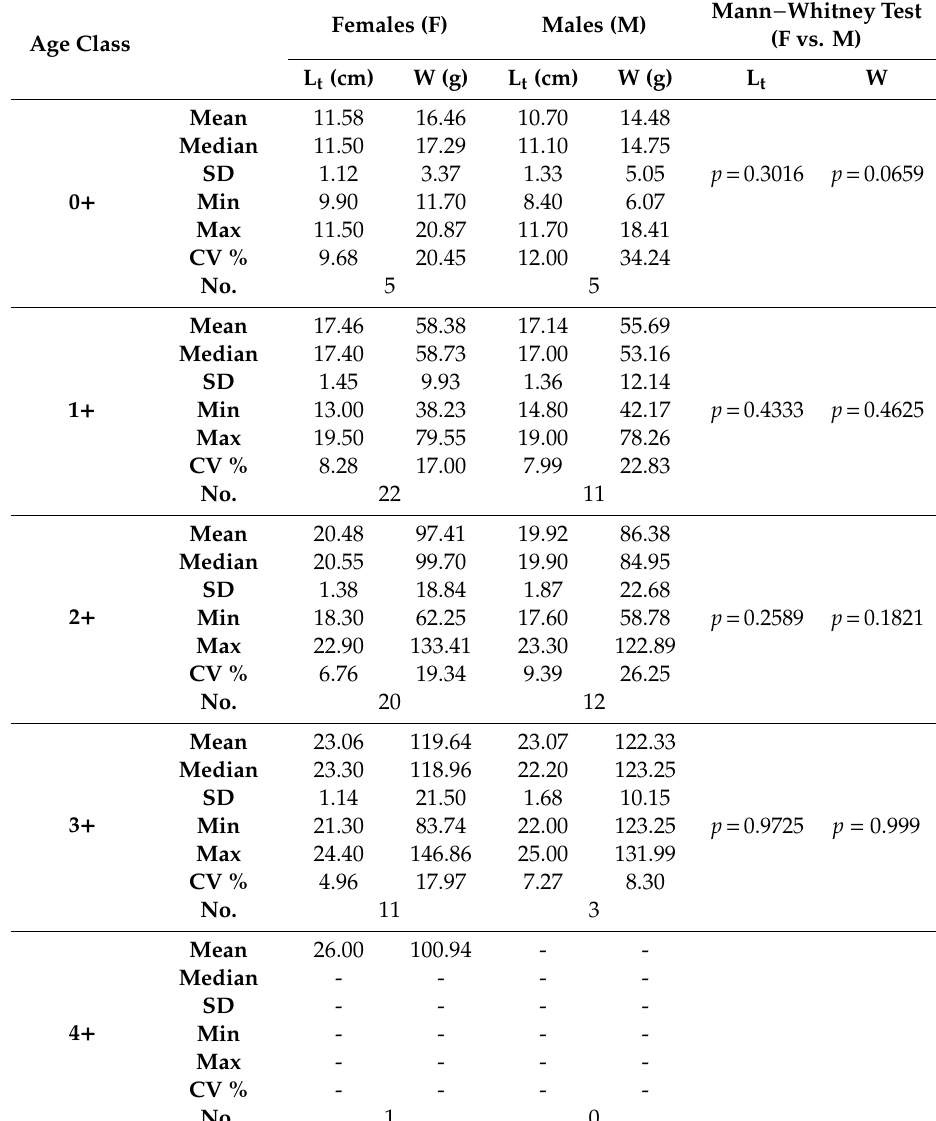
Table 4. Total length L t (cm) and total weight W (g) of male and female S. fontinalis (no.) for each age class.